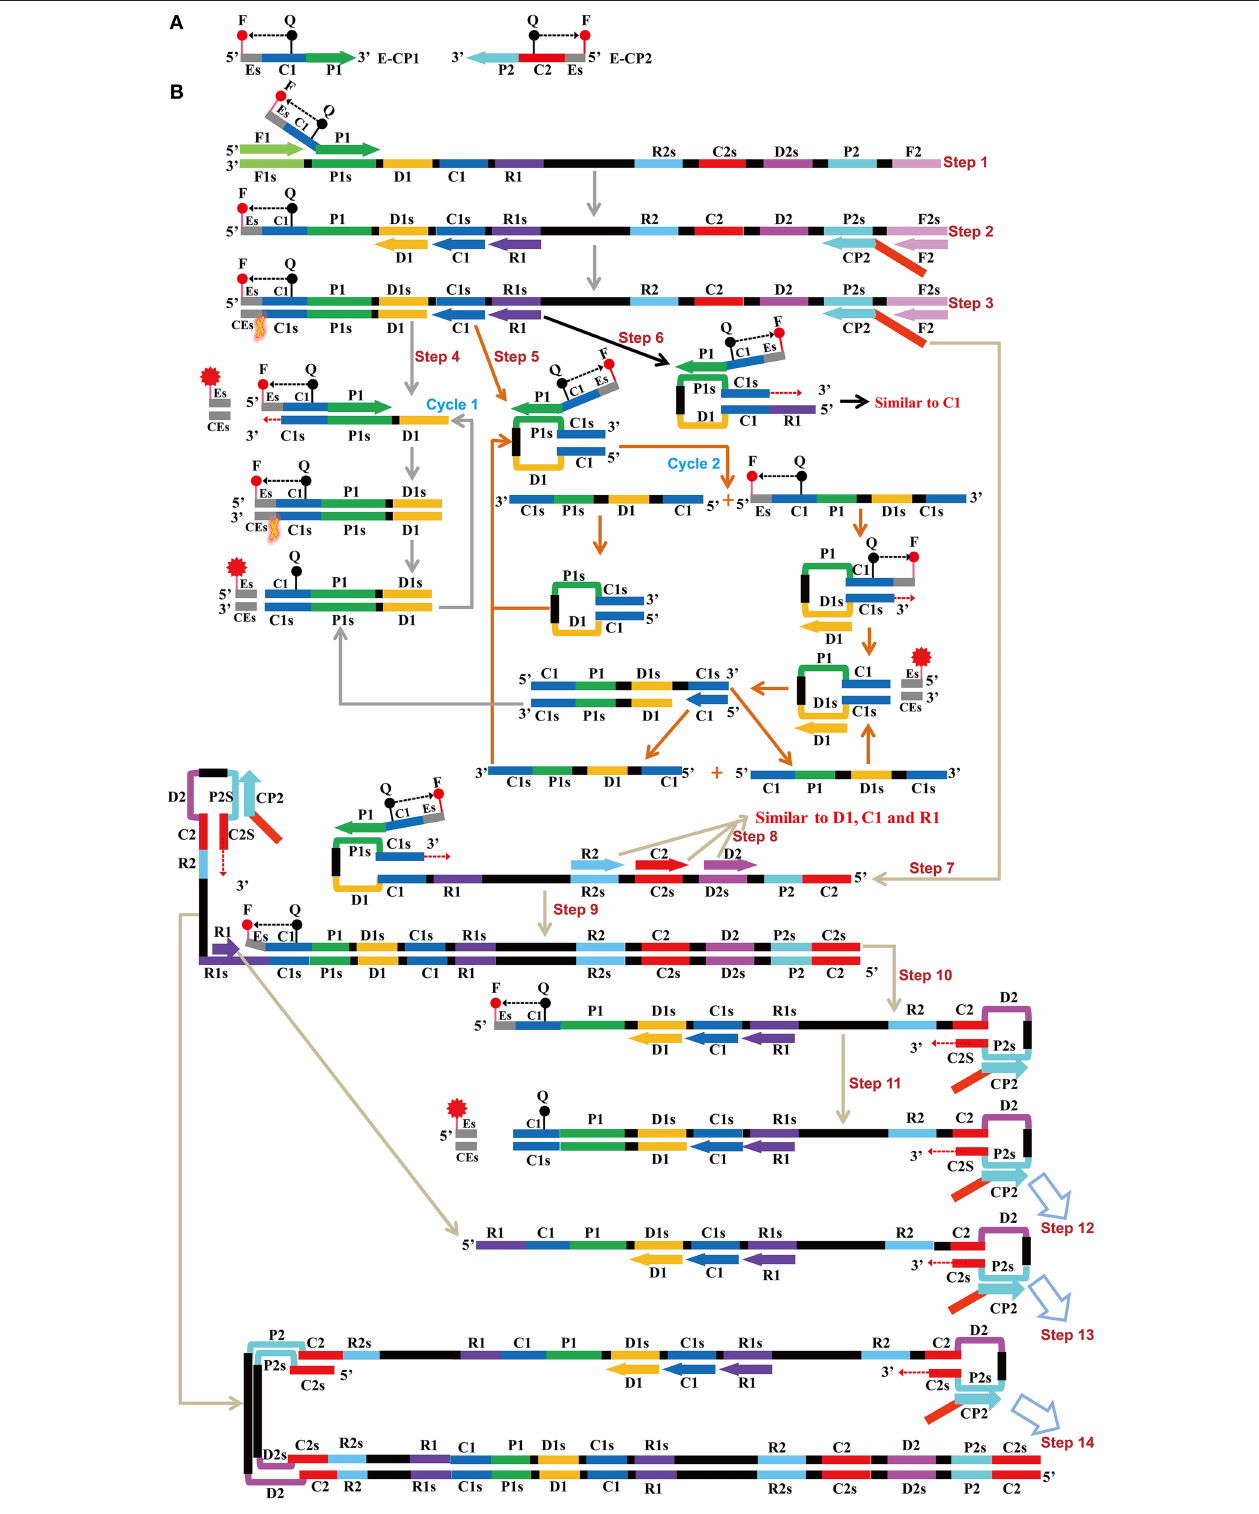
FIGURE 1 | Mechanistic description of the ET-MCDA amplification. (A) Schematic depiction of a new cross primer (E-CP1 or E-CP2). E-CP1/E-CP2, which was an extension of the cross primer CP1 (C1+P1)/CP2 (C2 + P2) with a restriction endonuclease recognition site (Es, its complementary sequence site termed CEs) at the 5 ′ end, was modified with a fluorophore (F) at the 5 ′ end and a quencher (Q) in the middle. (B) The outline of ET-MCDA amplification. Step 1: The E-CP1 initiates